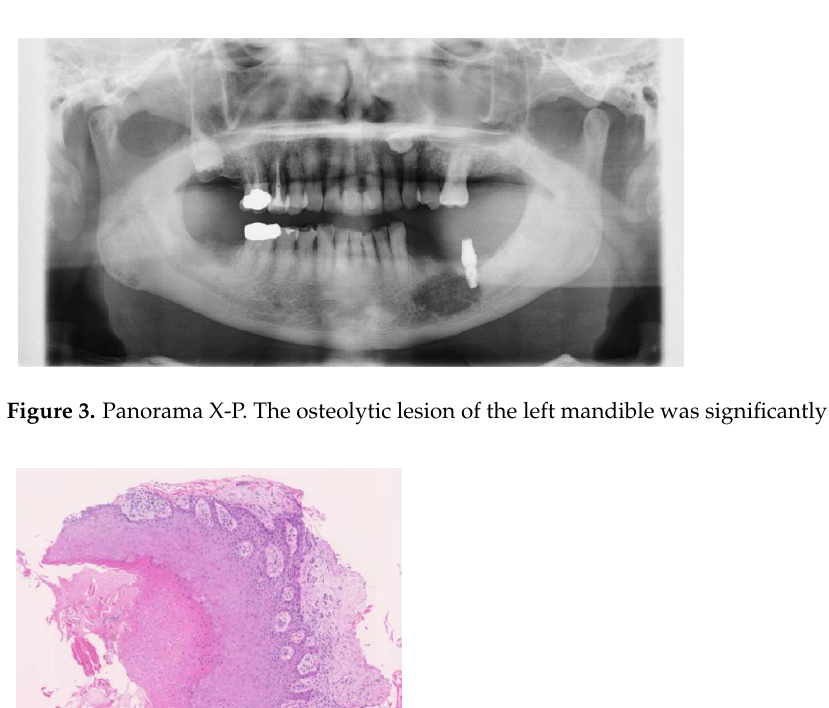
Figure 4. Photomicrograph of the biopsy. Epithelial components were found in the lesions in the mandible, but there were few findings to diagnose it as neoplastic, and pemphigus vulgaris and osteomyelitis was considered to have spread from peri-implantitis. Stain, hematoxylin and eosin (H&E); magnification, original ×125.